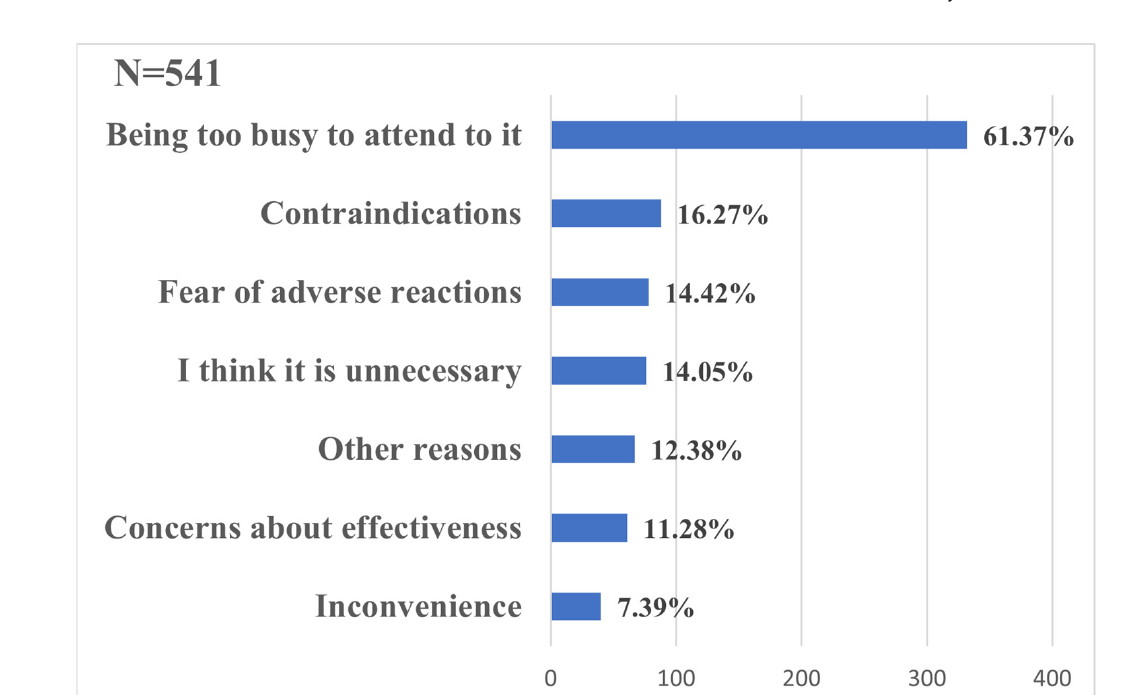
Figure 3. Reasons for not receiving a COVID-19 booster dose (%) among college students in China (N = 541). Table 3. Uptake of COVID-19 booster dose among Chinese college students who got full vaccination with the adenovirus vector vaccine or the inactivated vaccine (N = 2607).